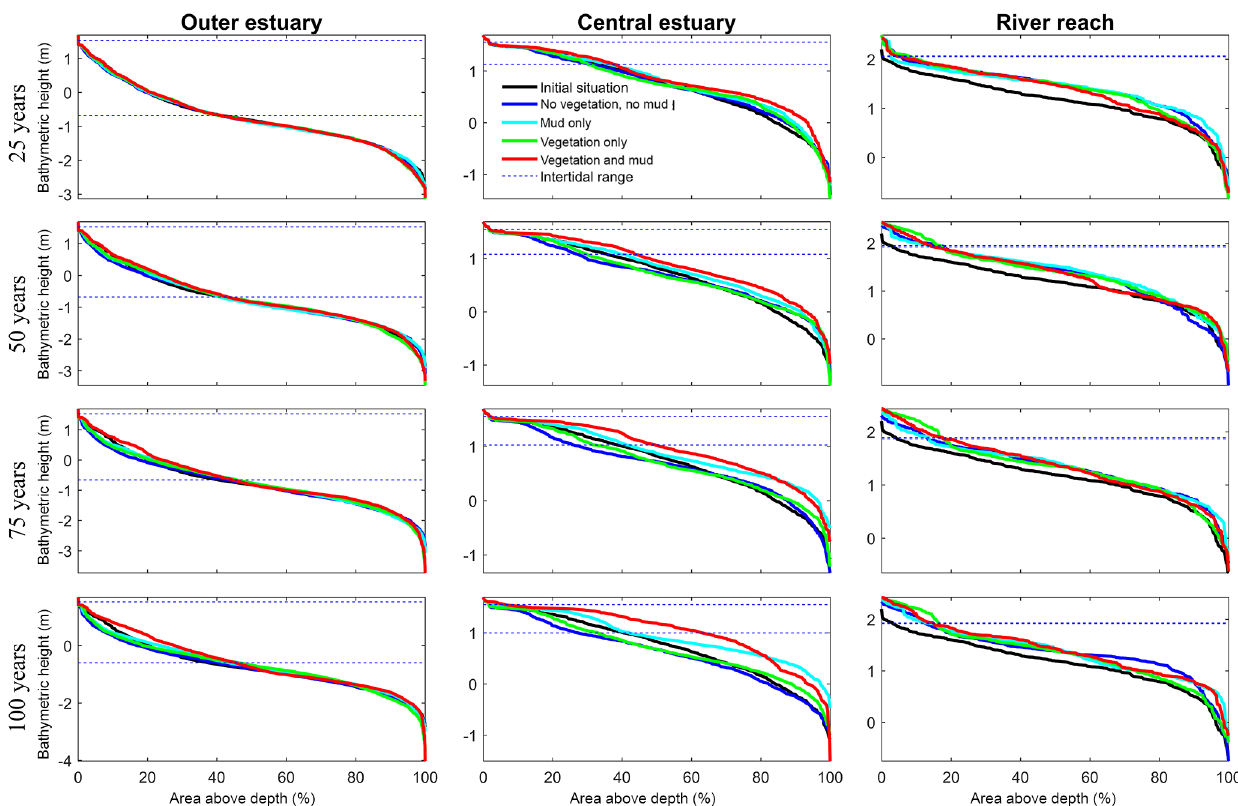
Figure 8. Development of hypsometry of three zones in the modelled estuaries. The outer estuary has a concave shape while the central and river areas have a convex shape. The middle part shows significant deposition compared to the outer estuary in simulations with mud and vegetation. Blue lines indicate initial minimum and maximum water surface